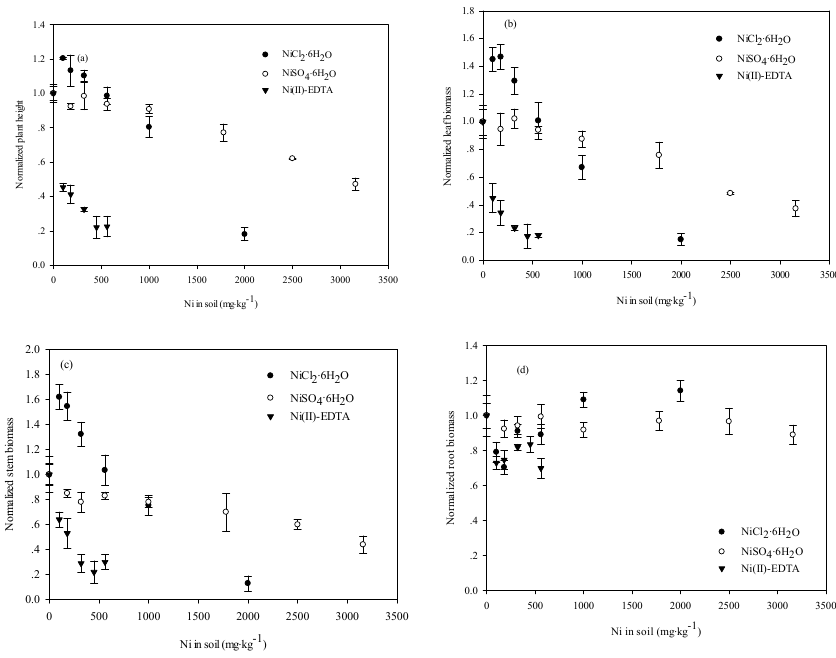
Figure 3. The dose-dependent response of the ( a ) plant height, ( b ) leaf biomass, ( c ) stem biomass, and ( d ) root biomass of maize seedlings to NiCl 2 ·6H 2 O, NiSO 4 ·6H 2 O, and Ni(II)-EDTA added to the soil. Maize seedlings were sampled at 28 days after emergence. The normalized values for different treatments were calculated in reference to the control, and the error bars represent the standard errors of the means.